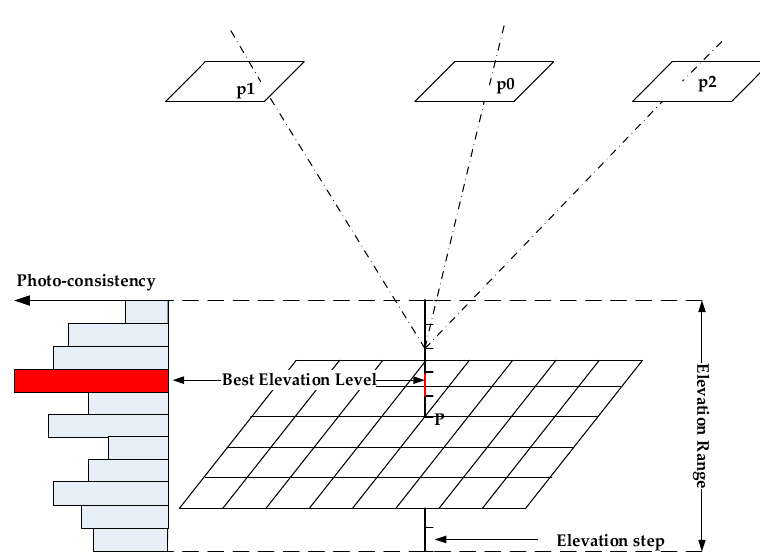
Figure 1. Vertical line locus method for Digital Surface Model (DSM) generation. Generation of DSM assigns elevation to each 2D planar grid point and the elevation of a grid point could be calculated as follows. Given elevation range and step, grid point P can get a photo-consistency (negatively correlated to matching cost) for each elevation level with all the visible projected points on the images, such as p 0, p 1 and p 2. The elevation for P will be achieved by the level which has the best photo-consistency (the lowest matching cost).